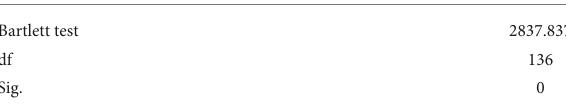
TABLE 5 Confirmatory factor analysis.